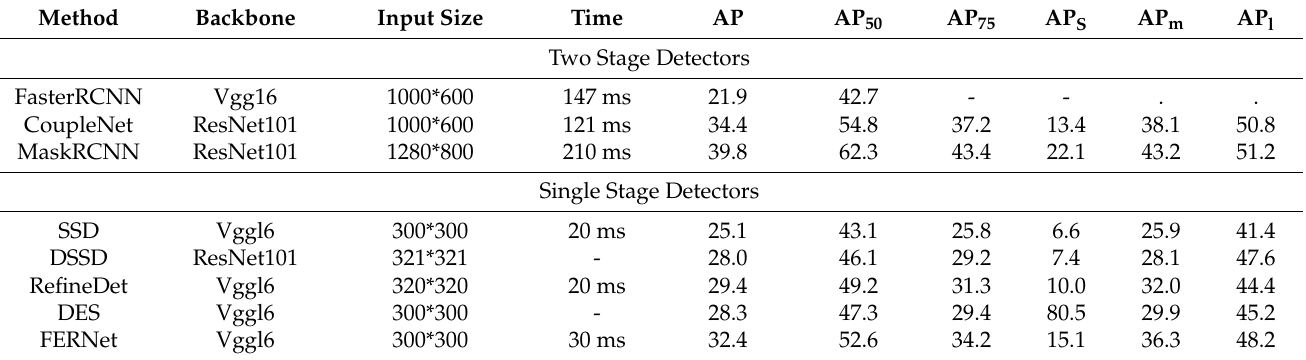
Table 2. Detection results of MS COCO 2015 dataset.